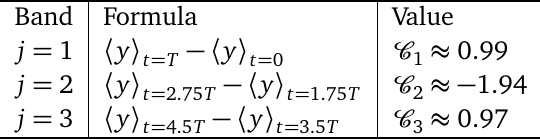
Table 1: Chern numbers extracted from the data in Fig.